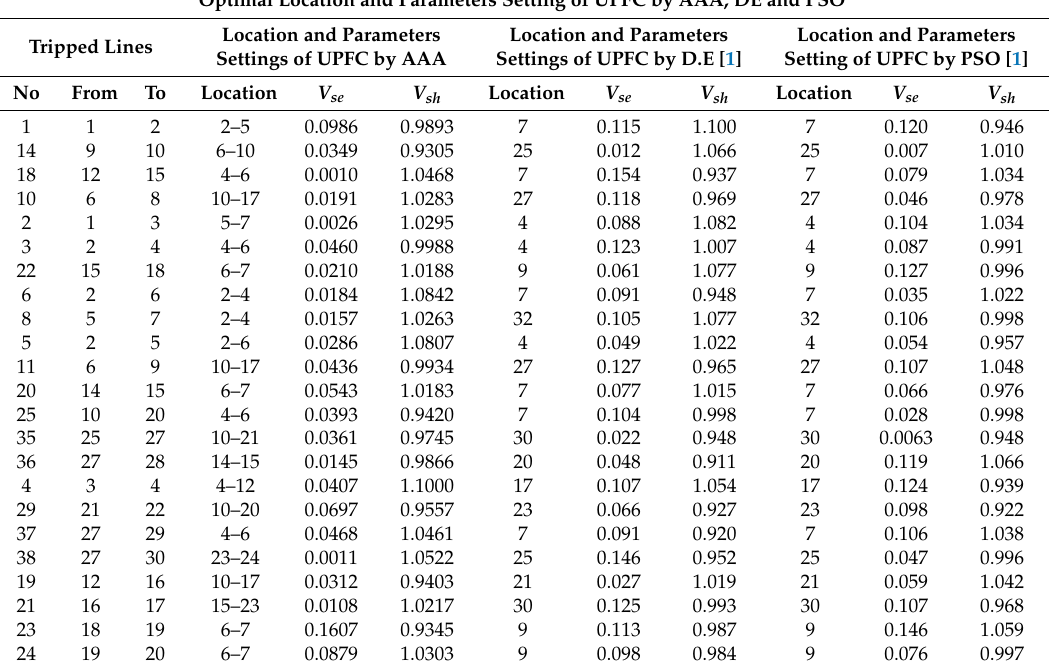
Table 10. Optimal Location and Parameters setting of UPFC by AAA, D.E and PSO (after 100 trials). Optimal Location and Parameters Setting of UPFC by AAA, DE and